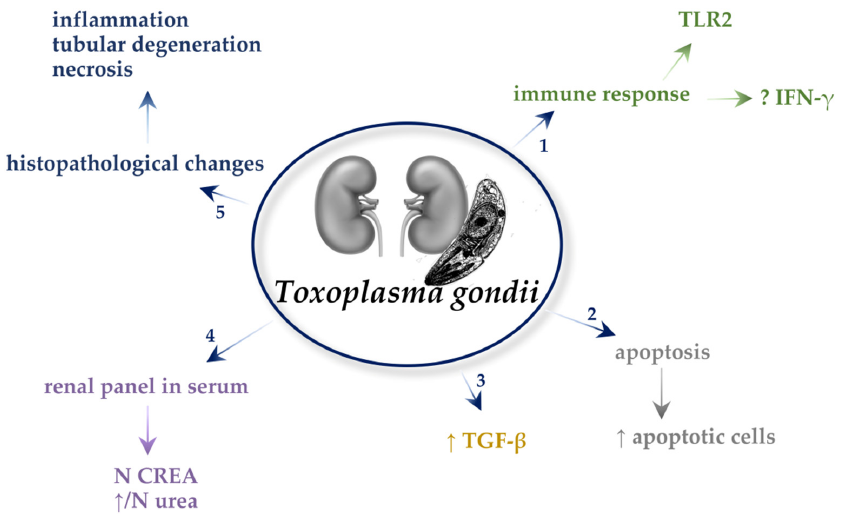
Figure 3. Mechanisms in Toxoplasma gondii -infected kidneys. 1. TLR2 has a protective role in kidney function against T. gondii infection. While studies about IFN- γ varied, it is reported that IFN- γ inhibits the replication of T. gondii in the kidneys and that it does not play a role in the protection of the renal function against T. gondii infection. 2. The percentage of apoptotic cells was higher in the kidneys with T. gondii infection. 3. Toxoplasma gondii cause increased expression of transforming growth factor β (TGF- β ). 4. Toxoplasma gondii cause no difference in serum creatine (CREA). The urea level may be elevated or in normal ranges. 5. The parasites cause inflammation, tubular degeneration, and necrosis in the kidneys.